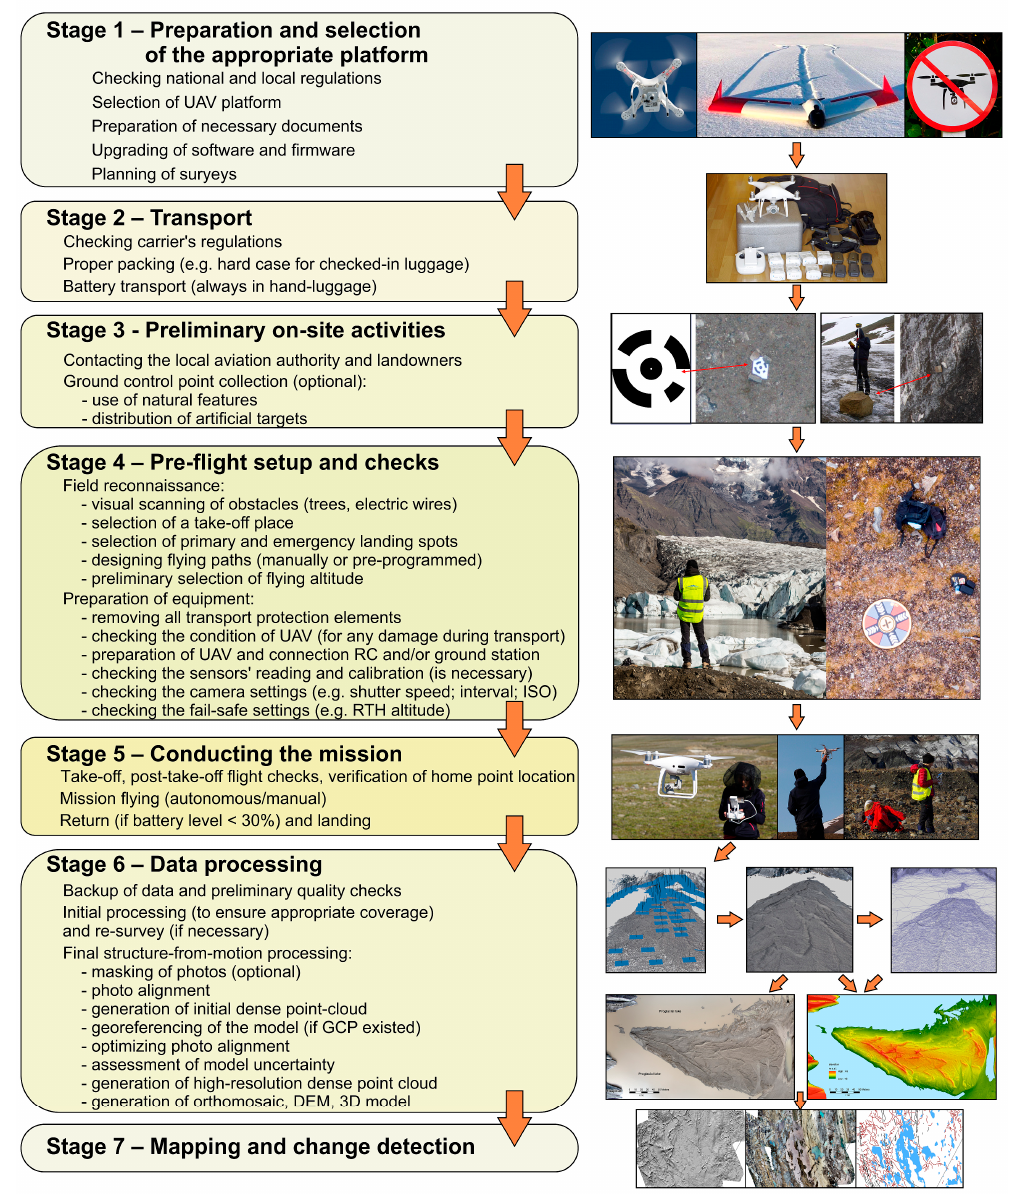
Figure 2. Operational framework for rapid mapping and monitoring of proglacial areas.